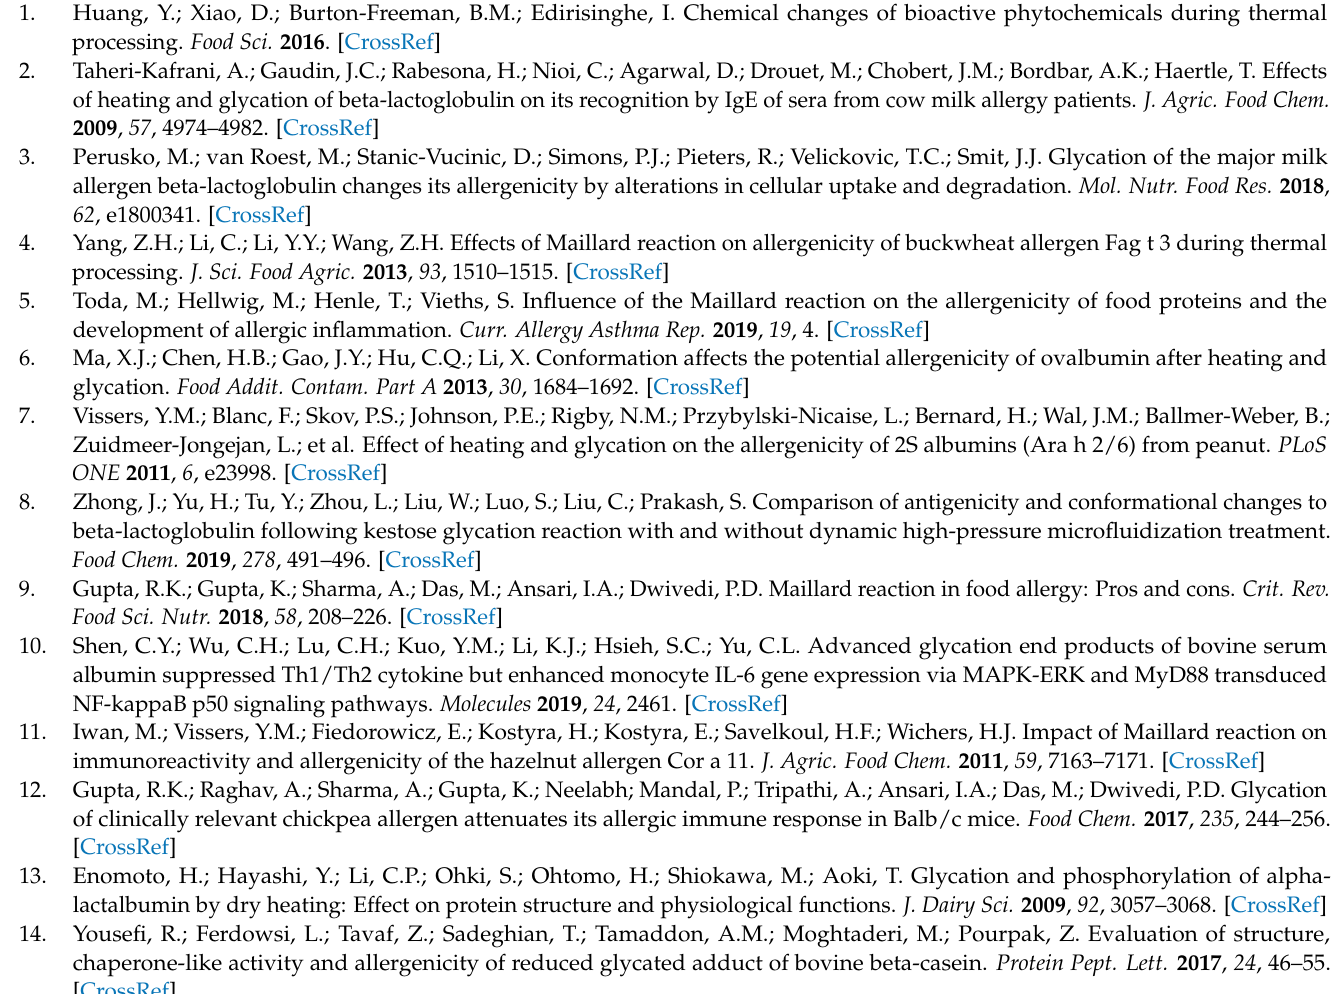
bare fused silica capillary. Table S2: Determination optimal resolution BLGWT separation. Table S3: Observed masses vs. theoretical masses as shown in figure 2. Table S4: Observed masses of intact BLG and conjugates. Table S5: Percental increase glycated peptides during first 8 hours. Figure S1: CE-MS analysis of